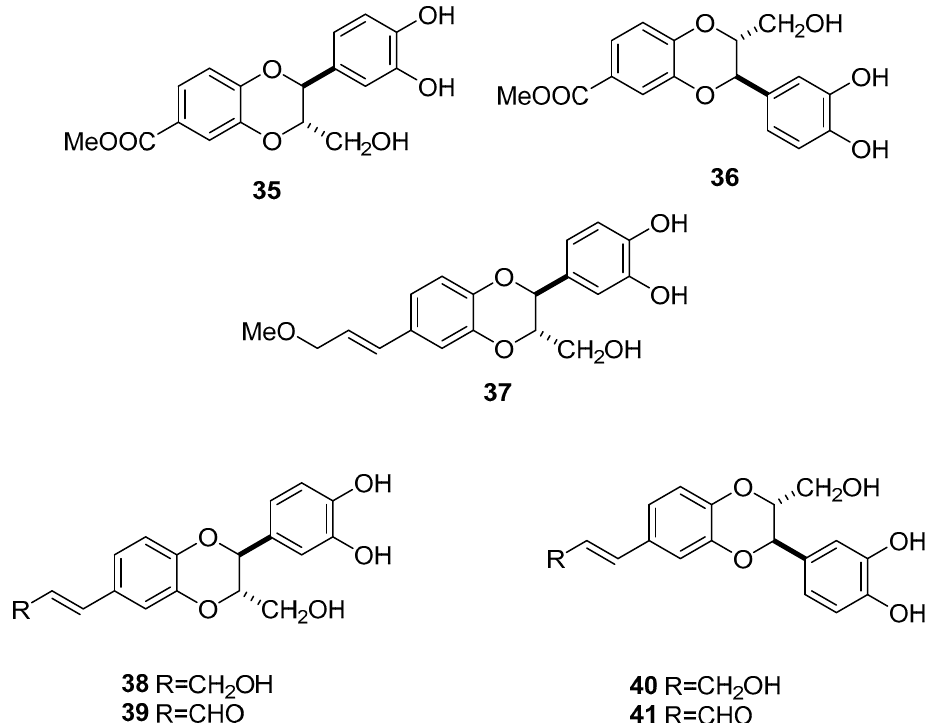
Figure 6. 1,4-benzodioxane derivatives of Phytolacca americana [46]. Americanoic acid methyl ester 35 , isoamericanoic acid A methyl ester 36 , 9 ′ - O -methylamericanol A 37 , americanol A 38 , americanin A 39 , isoamericanol A 40 , and isoamericanin A 41 . Table 3. Biological activity of extracts of Phytolacca